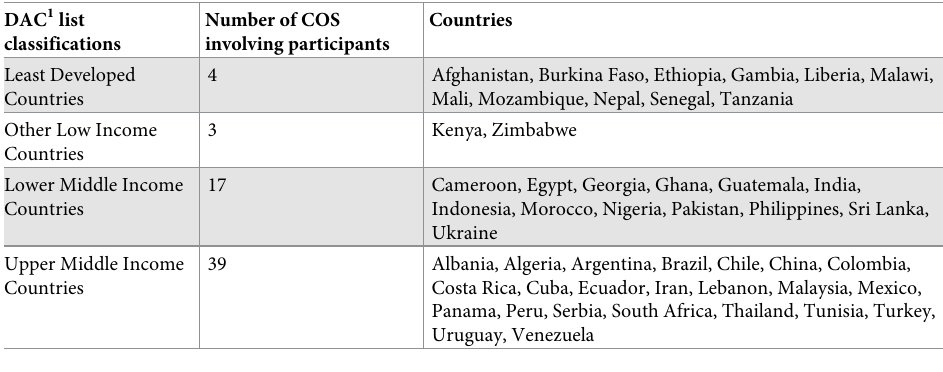
Table 7. OECD DAC list of ODA recipient countries involved in the COS development